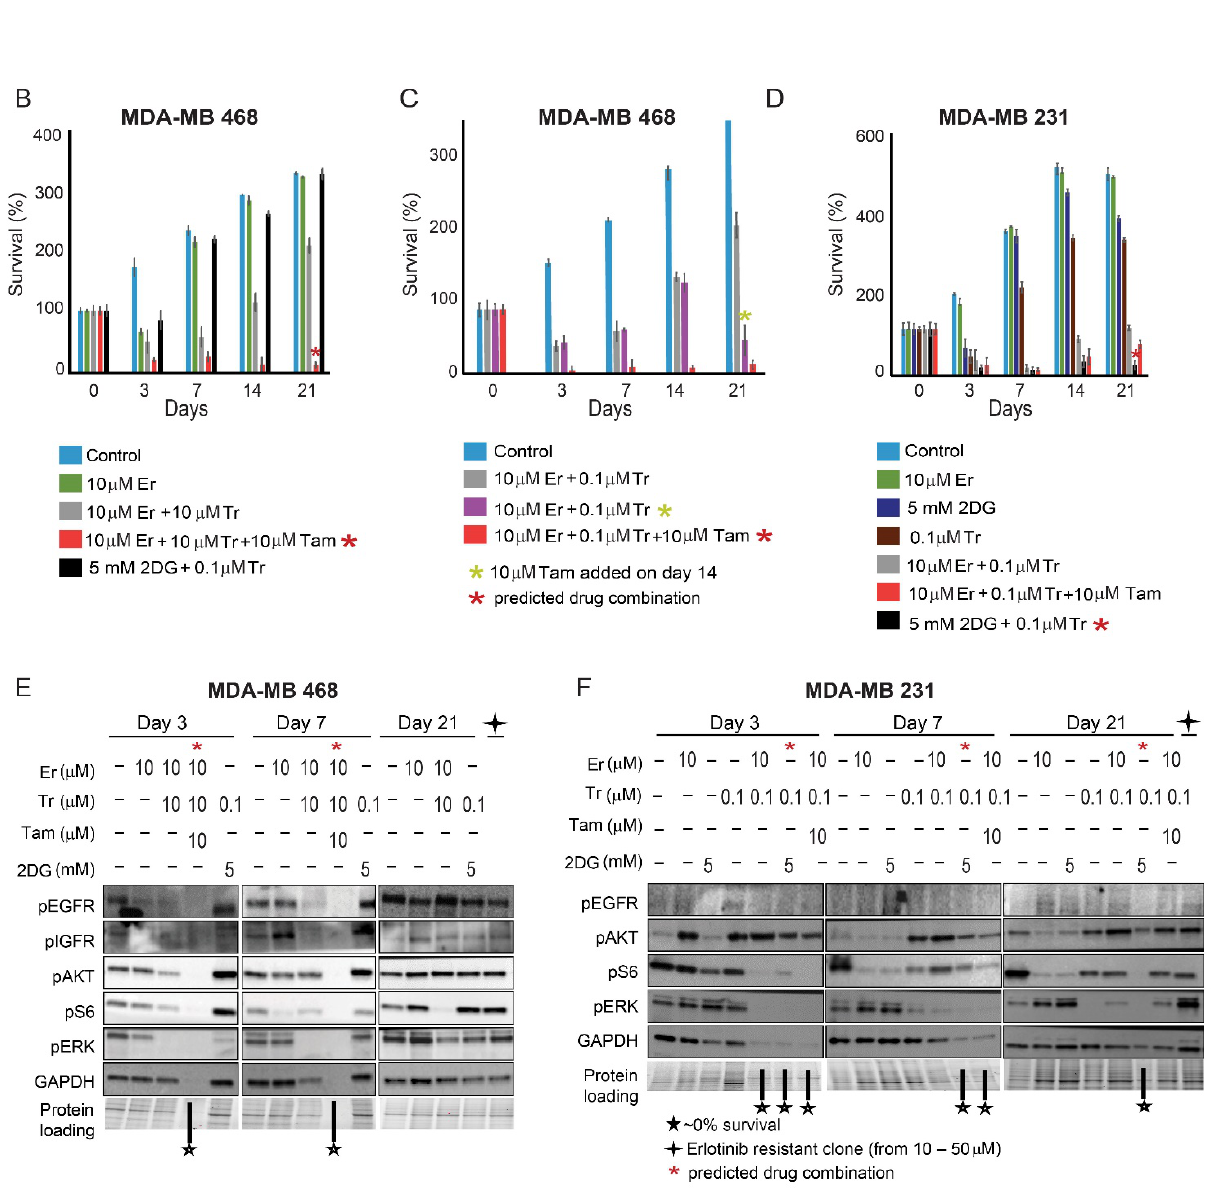
Figure 3. Development of resistance to various therapies. ( A ) The development of resistance to different types of therapies is shown in the illustration. Cells were treated for 72 h, allowed to regrow, and checked for survival; ( B ) In MDA-MB-468 cells, regrowth was detected when the cells were treated with Er monotherapy, Er + Tr, and also the combination predicted for MDA-MB-231 (Tr + 2DG), but not in the cells treated with the PaSSS-based therapy, Er + Tr + Tam; ( C ) Survival of MDA-MB-468 cells after the treatment with Er + Tr for 72 h. Cells were allowed to regrow until day 14, then Tam was administered on day 14 (purple columns); ( D ) MDA-MB-231 cells were treated with monotherapies, Er + Tr, Tr + 2DG, or Er + Tr + Tam, once a week for 21 days. The cells regrew after 21 days; however, no regrowth was detected when the cells were treated with Tr + 2DG; ( E ) Western blot analysis of MDA-MB-468 cells. The cells were treated with different monotherapies and combinations of drugs at different time points as indicated. Er resistant cells were developed by treating the cells with increasing amounts of Er for ~6 weeks. Due to ~0% protein content at day 21 (low survival following the PaSSS-based treatment), the results for Er + Tr + Tam treated cells are not present at day 21; ( F ) Western blot analysis of MDA-MB-231 cells. The cells were treated with different monotherapies and combinations of drugs at different time points as indicated. The Er resistant cells were developed by treating the cells with increasing amounts of Er for ~6 weeks. The results presented here represent at least 3 independent experiments. (Abbreviations: Er—Erlotinib, Tr—Trametinib, Tam—Tamoxifen, 2DG—2 deoxyglucose, pEGFR—phospho Epidermal Growth Factor Receptor, pIGFR—phospho Insulin Growth Factor Receptor, pAKT—phospho Protein kinase B, pS6—phospho Ribosomal protein S6, GAPDH—Glyceraldehyde 3-phosphate dehydrogenase, pERK—phospho Extracellular signal-regulated kinase, PaSSS—Patient-specific signaling